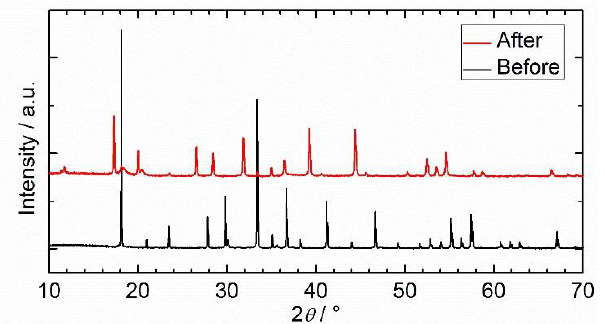
Figure 8. PXRDs for the reactivity test of (d) C12A7e − (3C) in THF with 5 mL H 2 O addition after 72 h and following drying under vacuum. Initial diffraction pattern (black) shows C12A7 and minor krotite (CA) reflections. The PXRD after the experiment (red) shows mainly Al 2 Ca 3 (OH) 12 reflections and minor Al 2 Ca 4 (OH) 12 CO 3 · 5H 2 O.